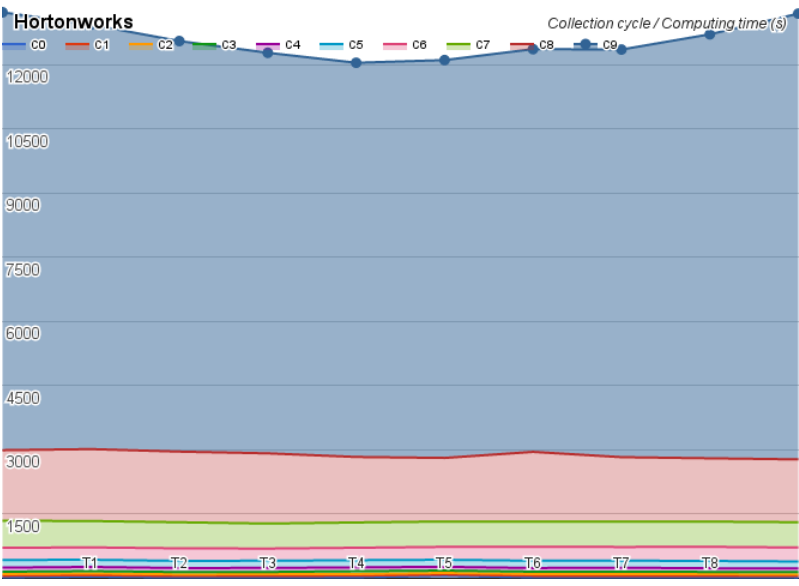
Figure 5. Hortonworks benchmark time (seconds)